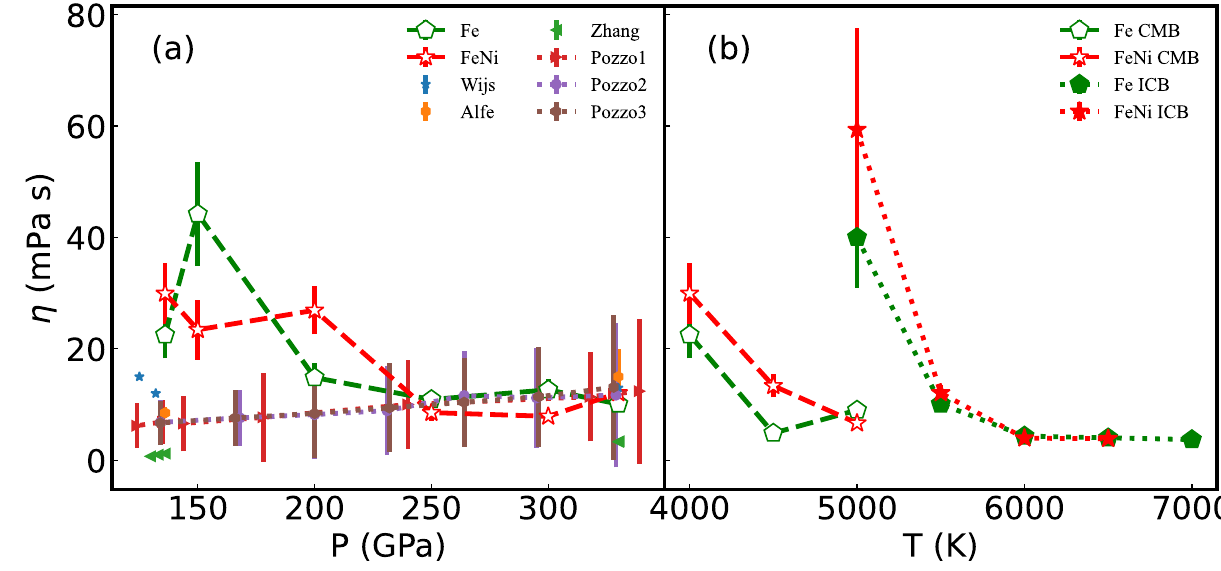
Figure 4. Viscosity of the pure Fe and FeNi fluid under Earth’s core condition. ( a ) is viscosity along the adiabatic curve and ( b ) is viscosity under inner-core (136 GPa) and core-mantle (330 GPa) boundary pressure with different temperatures. The Fe and FeNi labels correspond to pure Fe and FeNi fluid results,